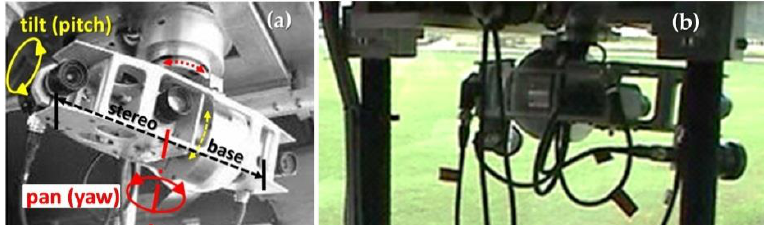
Figure 7. Purely experimental, roof-mounted 2-dof vehicle eye for VaMoRs in project AutoNav: ( a ) basic structure with three cameras mounted. ( b ) View from the rear within VaMoRs with the five cameras as used in AutoNav.